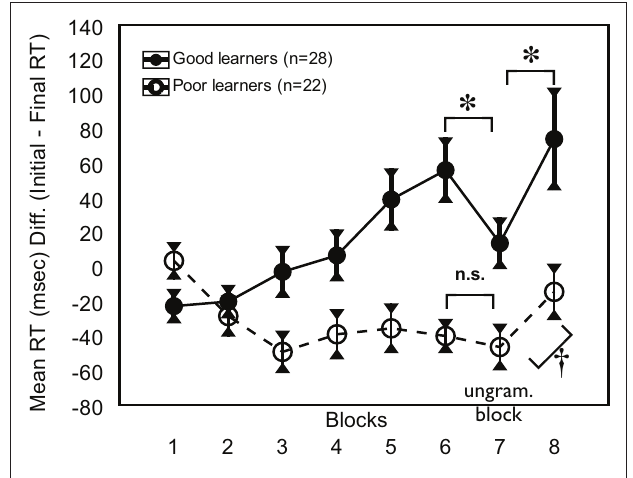
Figure 3 | Learning trajectories (as a plot of mean rT differences) for good and poor learners in experiment